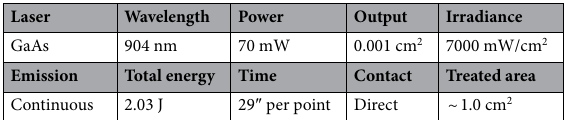
Table 1. PBMT parameters. GaAs = Gallium-Arsenide; nm = nanometers; mW = milliWatts; J = Joule; ( ″ ) = seconds; cm 2 = square centimeters; mW/cm 2 = milliWatts per square centimeter.